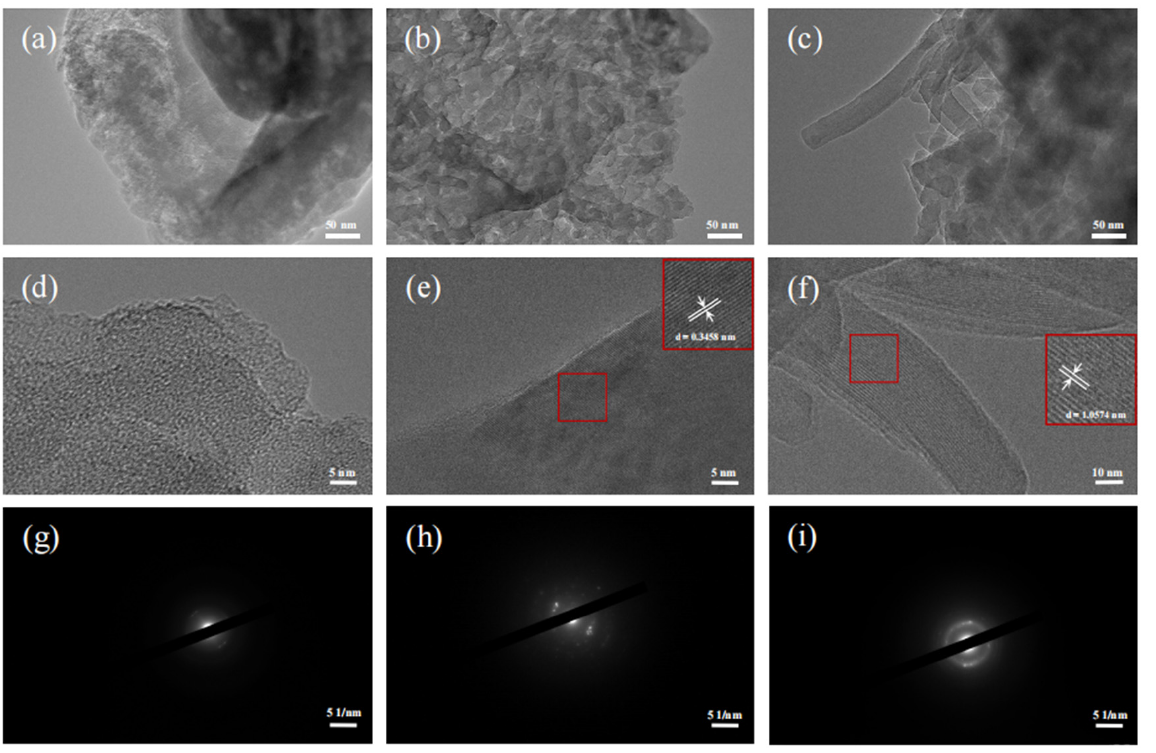
Figure 3. TEM images ( a , d ) and electron diffraction patterns ( g ) of g-C 3 N 4 ; TEM images ( b , e ) and electron diffraction patterns ( h ) of tri-C 3 N 4 ; TEM images ( c , f ) and electron diffraction patterns ( i ) of tri-s-tri-C 3 N 4 .